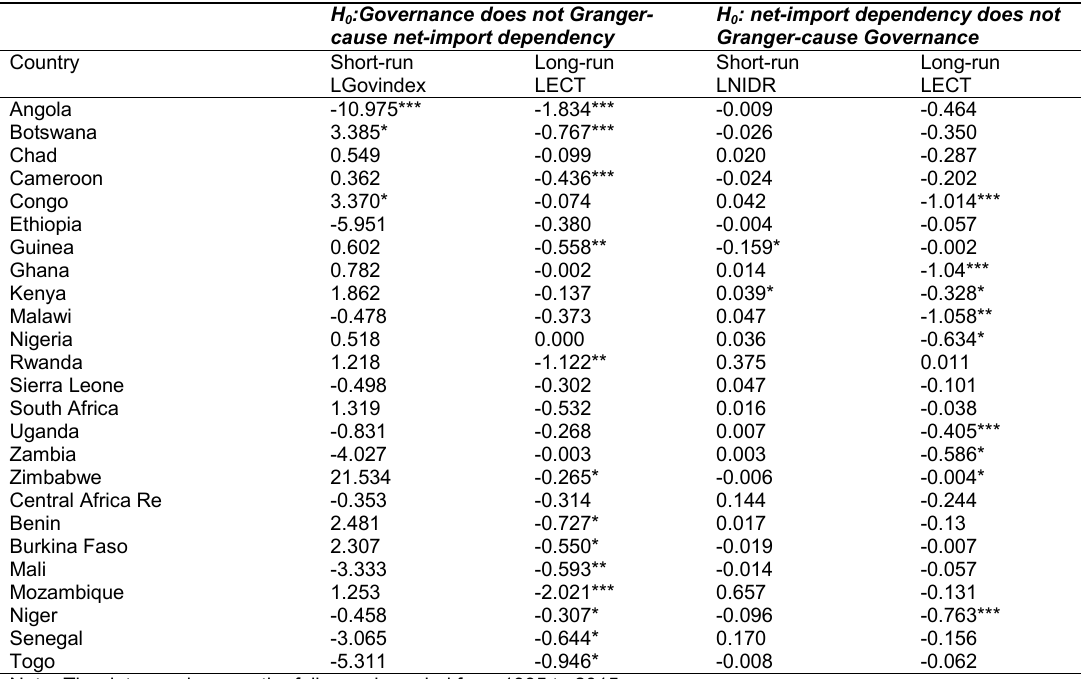
Table 9. Causality between governance and net-import dependency results. H 0 :Governance does not Granger- H 0 : net-import dependency does not cause net-import dependency Granger-cause Governance Country Short-run